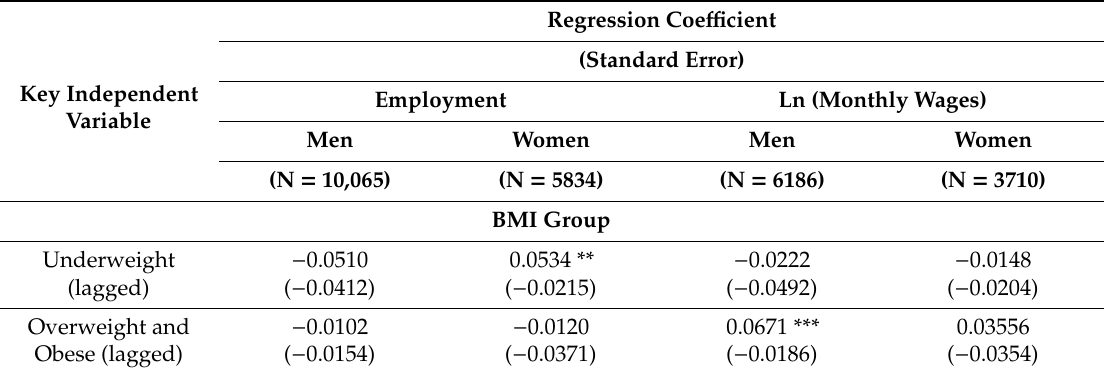
Table 3. Association between Y and BMI classification groups